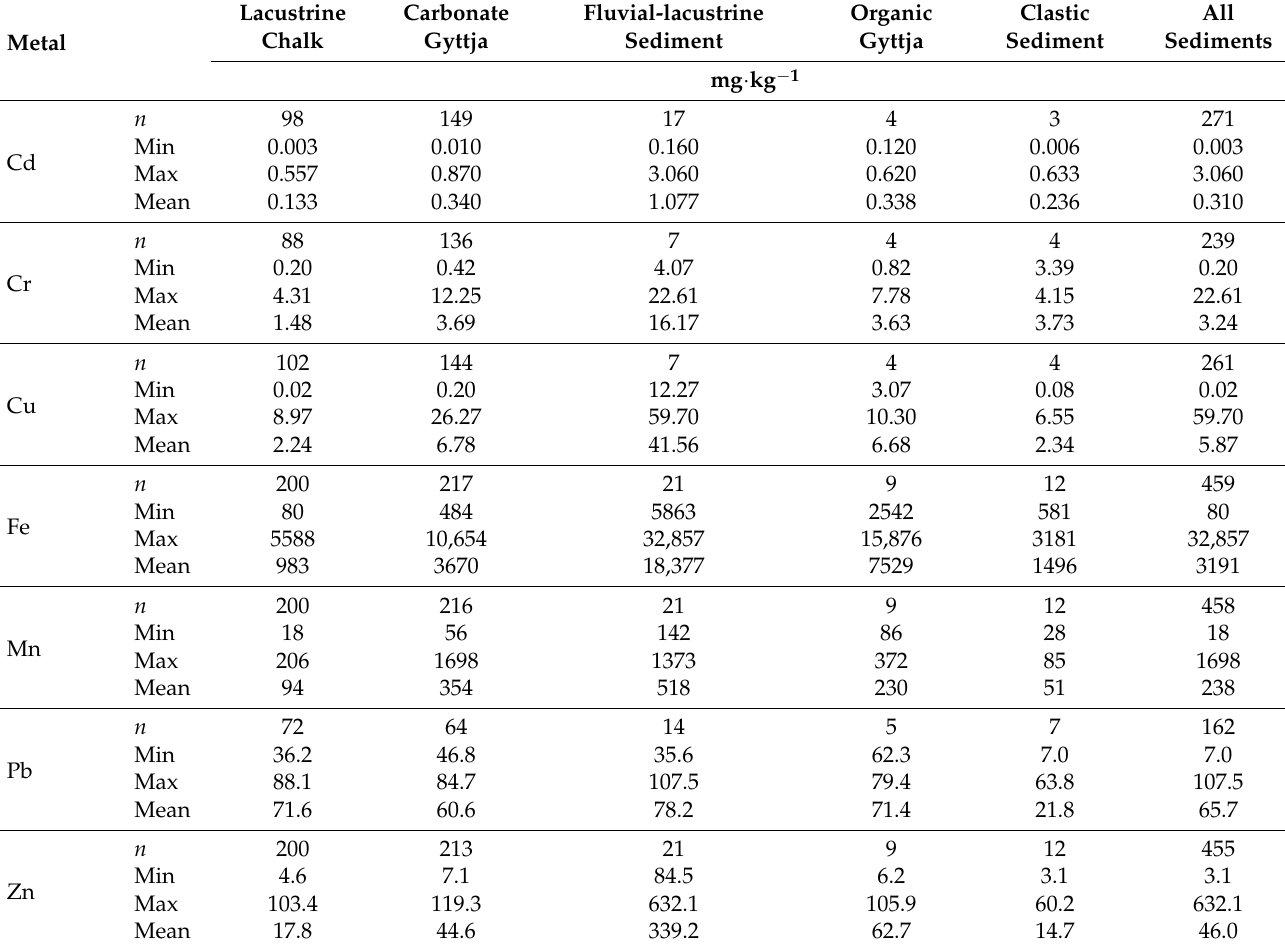
Table 2. Basic statistics for metal concentrations in different types of Wigry Lake sediments